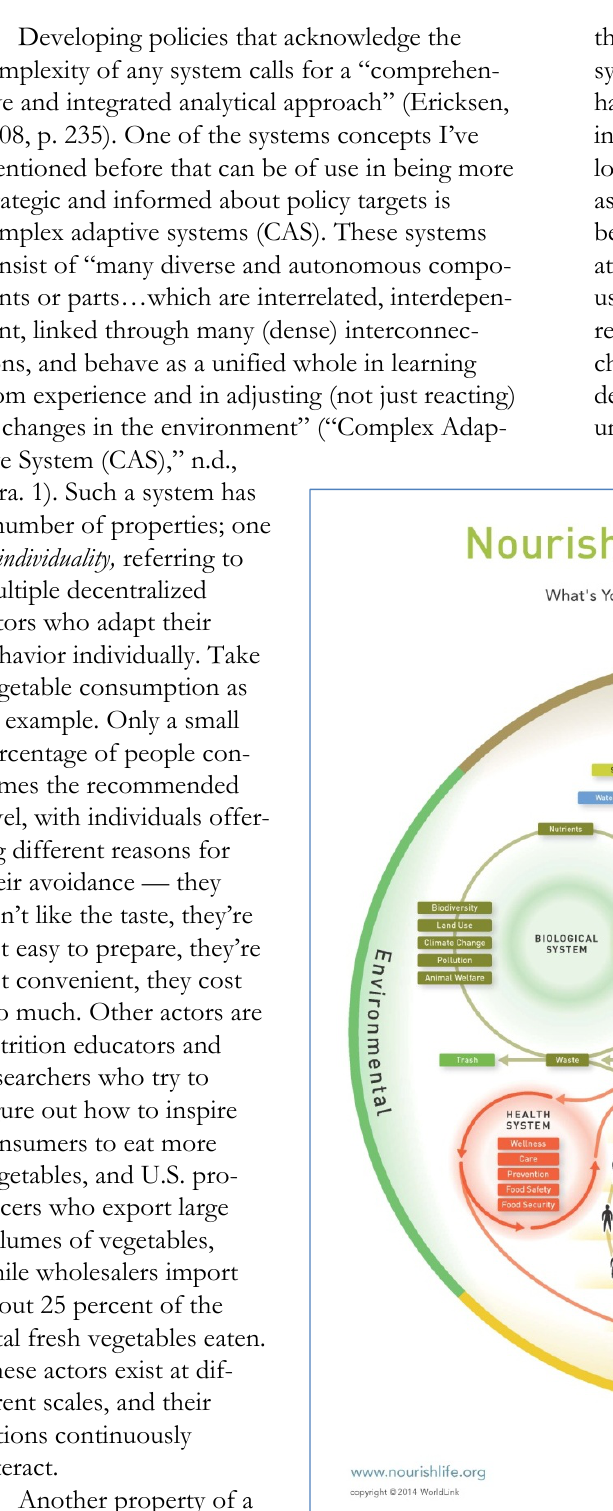
figure out how to inspire consumers to eat more vegetables, and U.S. pro- ducers who export large volumes of vegetables, while wholesalers import about 25 percent of the total fresh vegetables eaten. These actors exist at dif- ferent scales, and their actions continuously